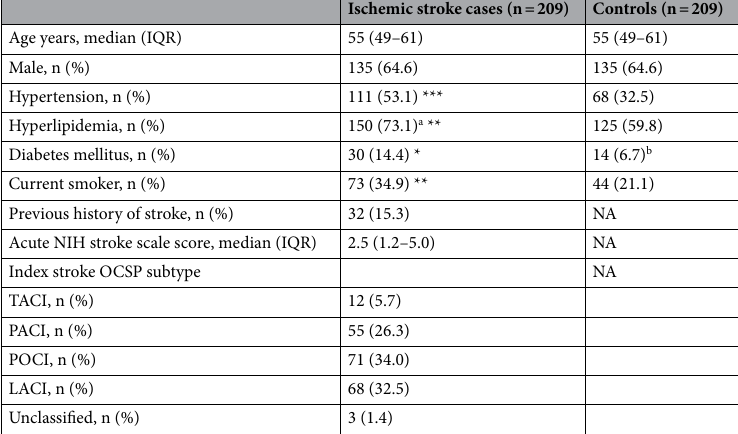
Table 1. Baseline characteristics. Difference in categorical variables between cases and the age and sex matched controls were tested by χ 2 test. IQR Interquartile range. NA Not applicable. NIH National Institutes of Health. OCSP Oxfordshire Community Stroke Project. TACI Total anterior circulation infarct. PACI Partial anterior circulation infarct. POCI Posterior circulation infarct. LACI Lacunar infarct. a Four cases with missing information. b One control with missing information. * p < 0.05, ** p < 0.01, *** p <